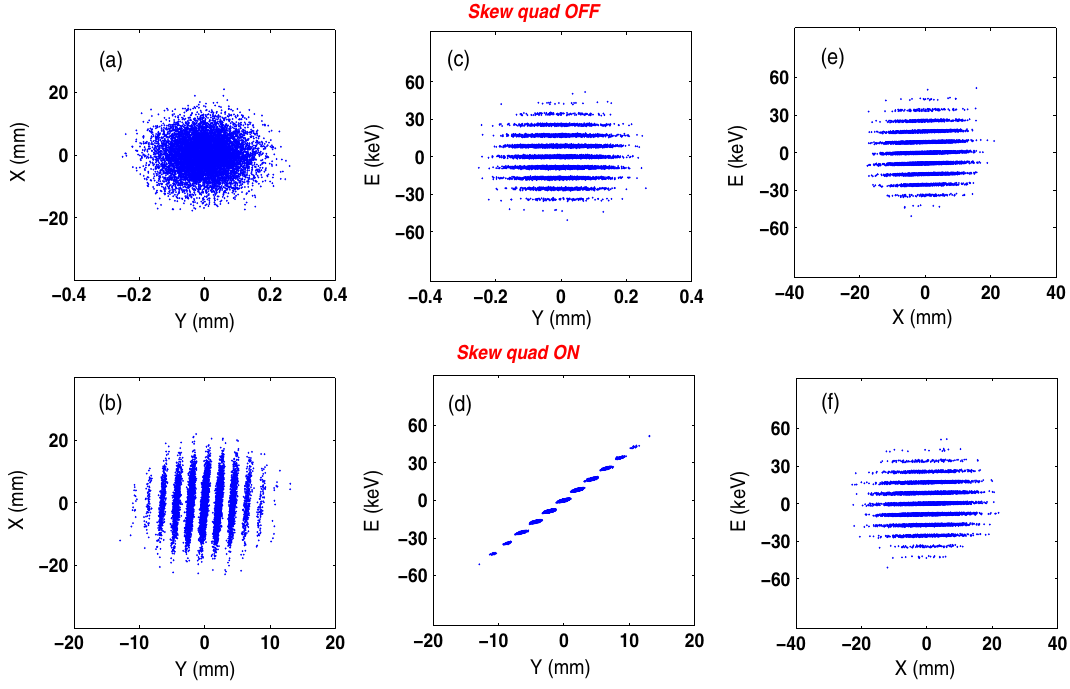
FIG. 9. BEAMLATTICE results showing the effect of the skew quadrupole at X23 with slits in at X3 and 5-cell on. Parts (a) and (b) show X vs Y transverse dimensions with the skew quadrupole off and on. Parts (c) and (d) show energy vs Y with the skew quadrupole off and on. Turning on the skew quadrupole couples dispersion in the vertical plane introducing a strong correlation between E and Y as shown in part (d) which is mapped on the screen thus acting as a vertical spectrometer [part (b)]. The X vs E plane shown in parts (e) and (f) is unaffected by turning on the skew quadrupole. The rms transverse beam sizes for the case with skew quad off at X23 was